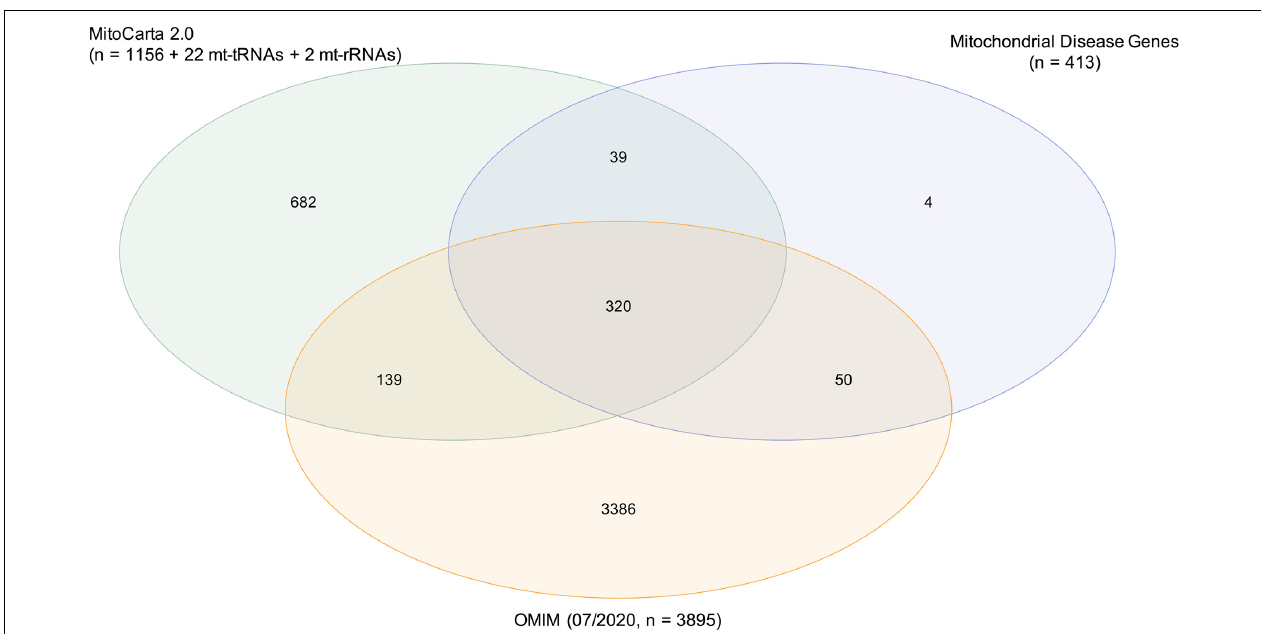
FIGURE 2 | Characterization of mitochondrial disease genes. Mitochondrial localization of encoded proteins was examined by using the mitochondrial proteome inventory MitoCarta2.0 (1156 genes). The 22 mitochondrial tRNAs and 2 mitochondrial rRNAs were also considered as mitochondrially localized. A total of 87% (359/413 genes) of mitochondrial disease genes were located in the mitochondrion. Annotation in the database OMIM (07/2020) served as prove for the pathogenicity of genes. A total of 90% (370/413 genes) of mitochondrial disease genes were annotated in OMIM with an associated phenotype and mode of